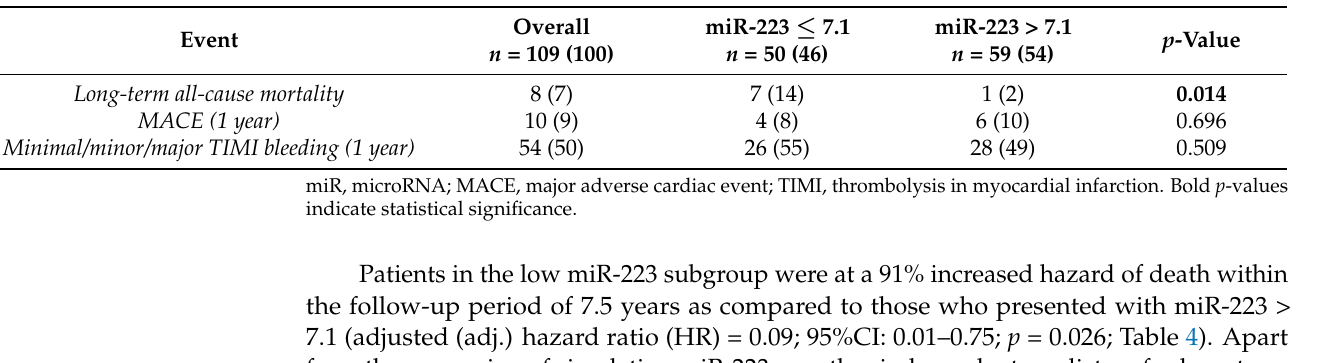
Table 3. Event data.